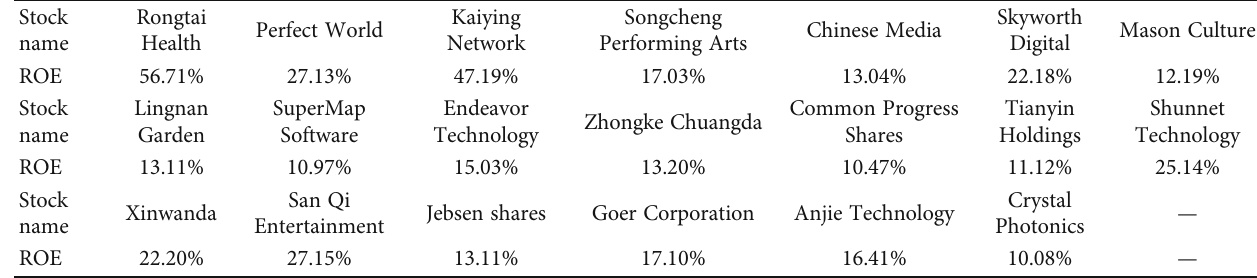
Table 2: Top 20 stocks with net return (ROE) greater than 10%.